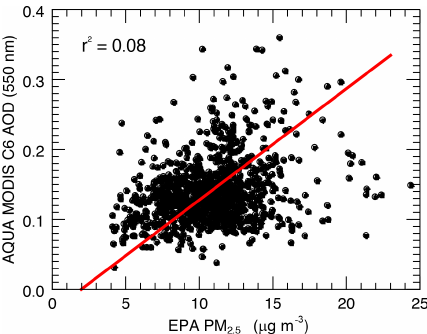
Figure 1. For 2008–2009, scatter plot of mean PM 2 . 5 concentra- tion from ground-based U.S. EPA stations and mean column AOD (550nm) from collocated Collection 6 (C6) Aqua MODIS observa- tions. The red line represents the Deming regression